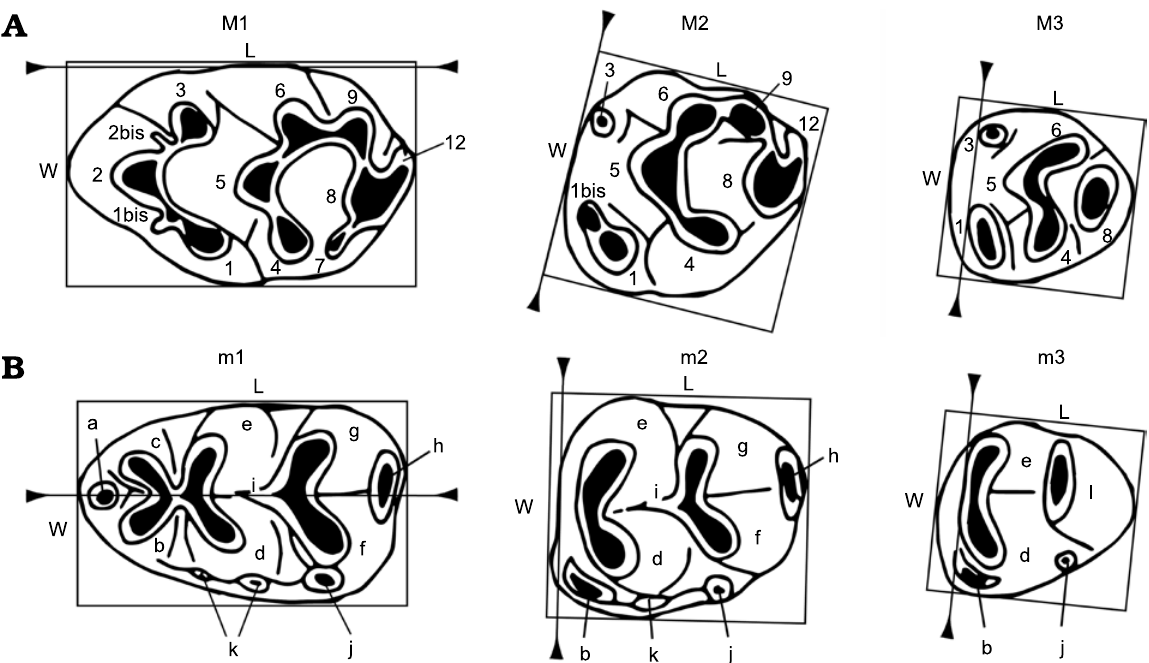
Fig. 2. Nomenclature used in the descriptions of dental elements (modified from Van de Weerd 1976; López-Antoñanzas et al. 2019) and measuring methods (Martín-Suárez and Freudenthal 1993). Length (L) and width (W) are measured as the smallest circumscribed rectangle with sides parallel and perpendicular to the reference line (indicated by triangles). A . Upper dentition (M1–M3): 1–12, tubercle (1–12); 1, anterostyle; 2, lingual anterocone; 1bis, 2bis, accessory cusps; 3, labial anterocone; 4, enterostyle; 5, protocone; 6, paracone; 7, posterostyle; 8, hypocone; 9, metacone; 12, posterior cingu- lum. B . Lower dentition (m1–m3): a, medial anteroconid (= tma); b, labial anteroconid; c, lingual anteroconid; d, protoconid; e, metaconid; f, hypoconid; g, ento conid; h, posterior cingulum; i, longitudinal spur; j, posterior accessory cuspid; k, accessory cuspids on the labial cingulum; l, posterior